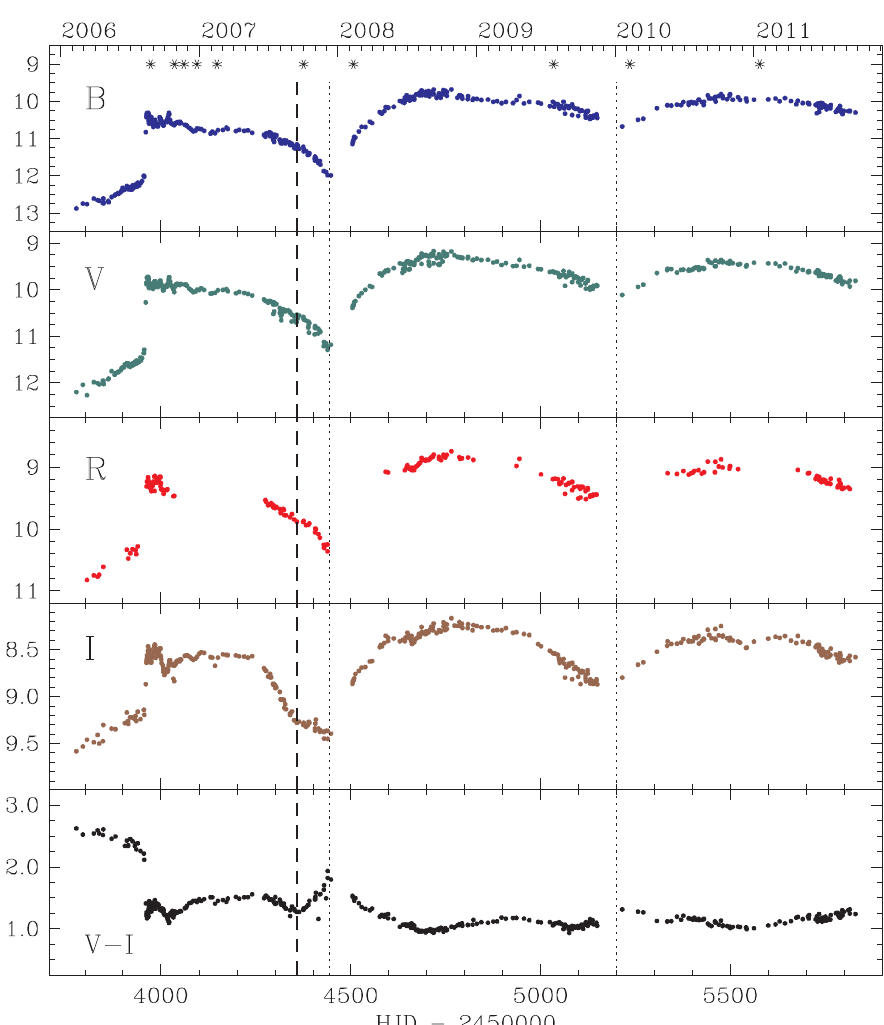
Fig. 2. The ANS Collaboration photometric observing campaign of BF Cyg. Dashed line marks the date of the 6376 d periodicity. Dotted lines mark the orbital periodicity according to the JD min = 2415065 + 757.3 (cid:2) E given by Pu(cid:20)cinskas (1970). The asterisks on the top panel mark the time when the spectra displayed in Figure 3 were